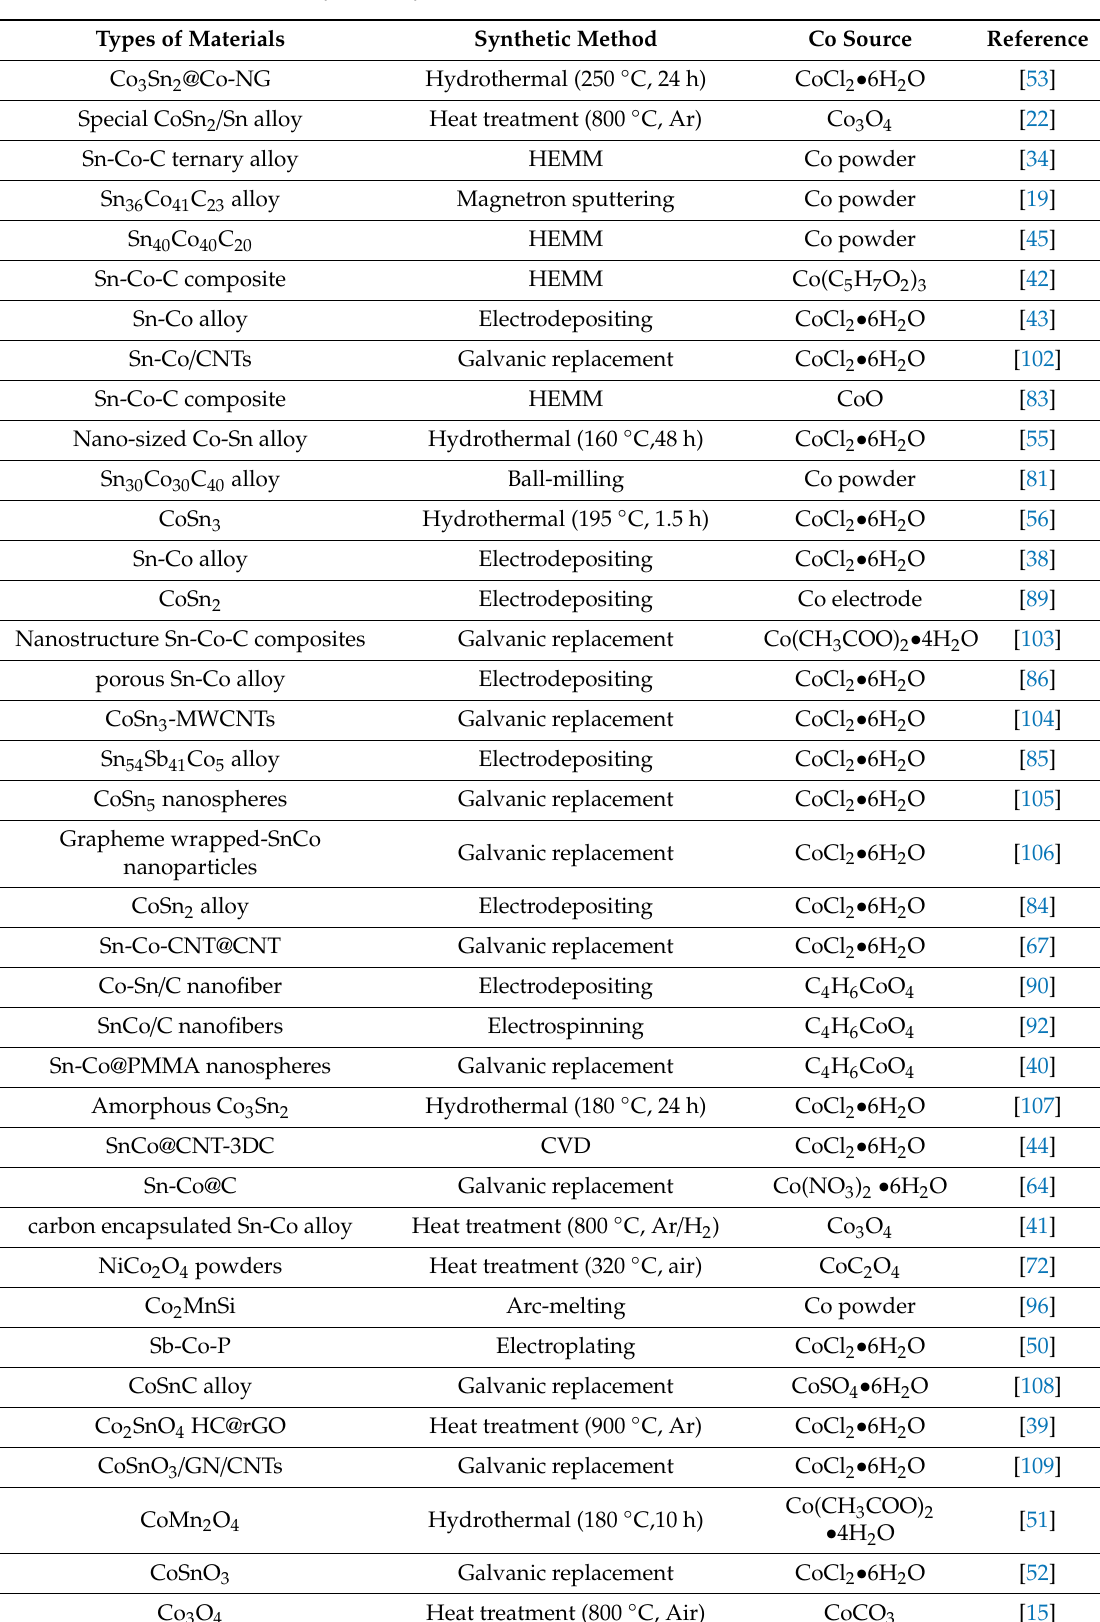
Table 2. Summary of the synthetic methods for cobalt-based electrode